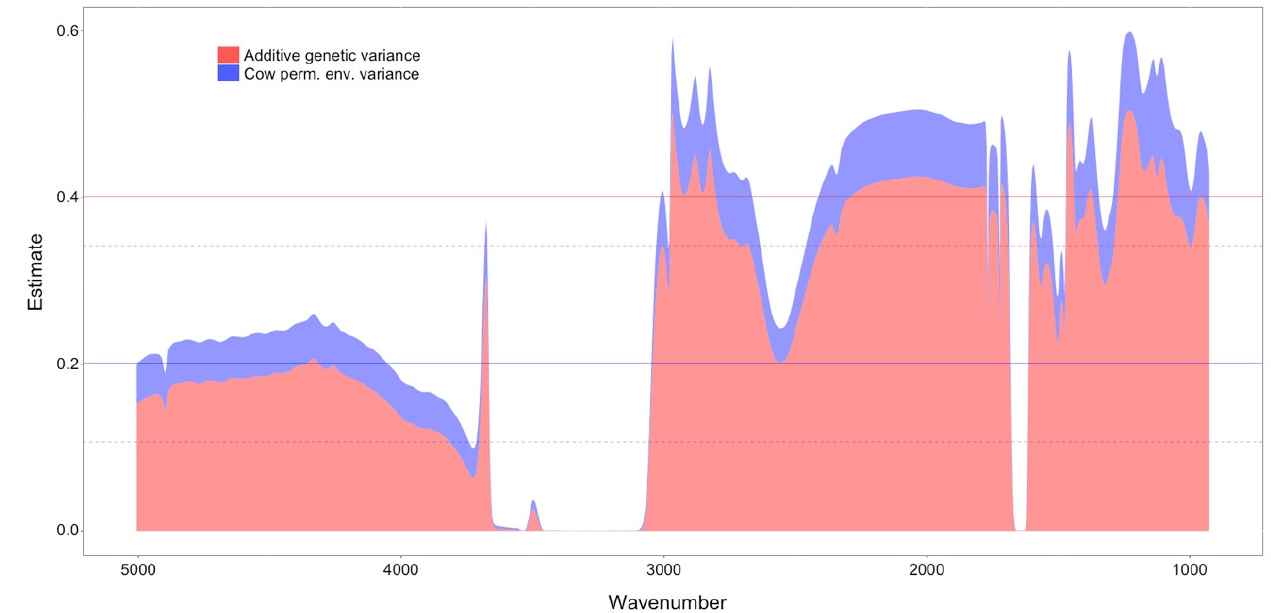
Figure 2. Heritability and repeatability for each of the 1060 wavenumbers used in the study. The solid blue and red lines report the heritability and repeatability estimates for milk yield, while the dashed lines report the same parameter estimates for somatic cell score. Each wavenumber refers to a specific wavelength in the infra-red range of the spectrum and show a discontinuous numbering that goes from 5010 to 925 cm − 1